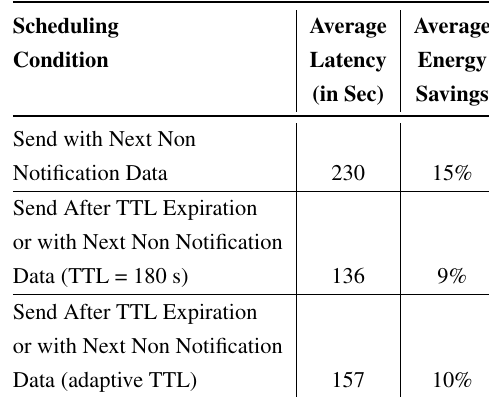
Figure 8: Energy Consumption vs Scheduling Heuristic